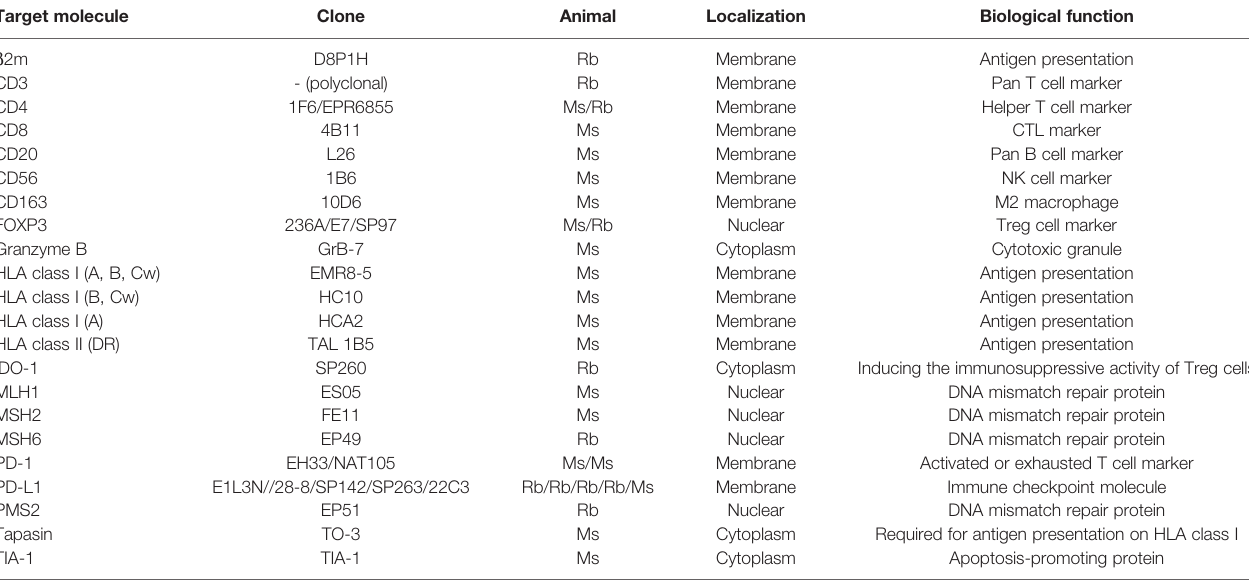
TABLE 1 | Representative antibodies for immunohistochemical investigation of human cancer immunity. Target